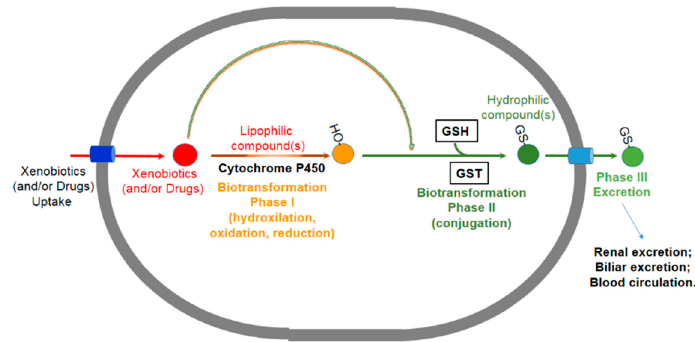
Figure 5. General biotransformation pathway of xenobiotics. Toxic compounds (e.g., endogenous, exogenous and drugs) inside the cell according to their chemical properties are taken over by the enzymes of different phases detoxification pathway. Lipophilic compounds are bio-transformed by Phase I enzymes (e.g., Cytochrome P450 family), more polar compounds are bio-transformed in Phase II reactions catalyzed by a second pool of enzymes (e.g., glutathione transferases). The final conjugated and more hydrophilic compounds will be transported out the cell by membrane channels, transporters and pumps (Phase III). Moreover, compounds with a polar or hydrophilic chemical nature may enter in Phase II or III respectively.